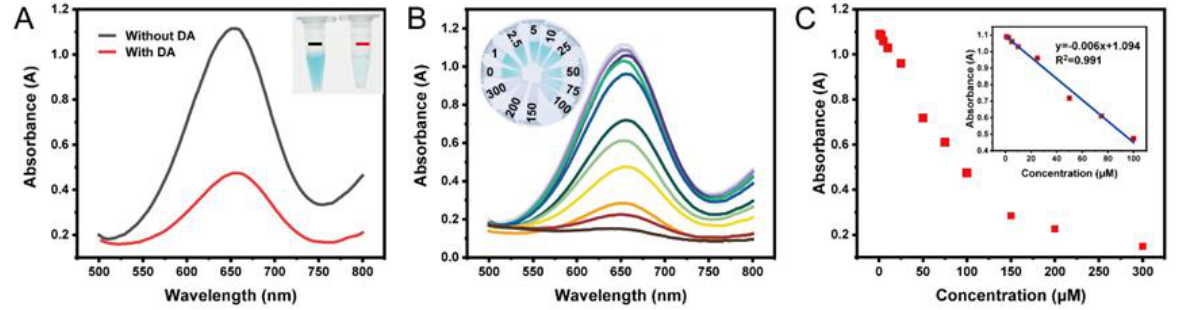
Figure 4. ( A ) The catalytic oxidation of TMB with and without DA. ( B ) UV-vis spectra of MoS 2 -based colorimetric sensor for different concentrations of DA (1 – 300 μM) detection. ( C ) Relationship of absorption peak intensity and DA concentration. All the experiments were carried out at 25 °C in pH 4 reaction mixtures containing 20 mM H 2 O 2 and 0.1 mM TMB.